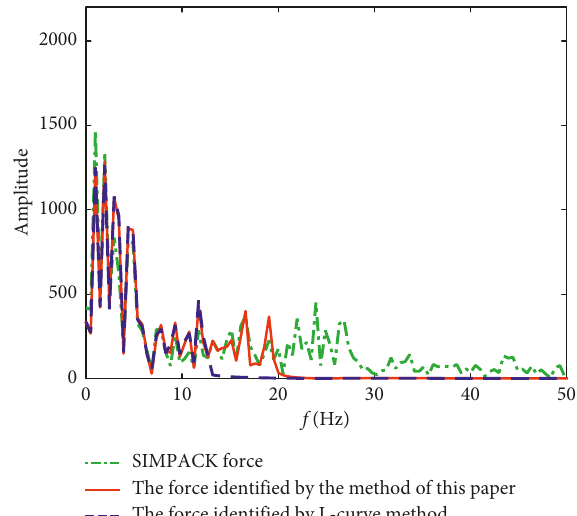
Figure 15: Amplitude-frequency curve of the two methods for F identification when the noise level is 10%.